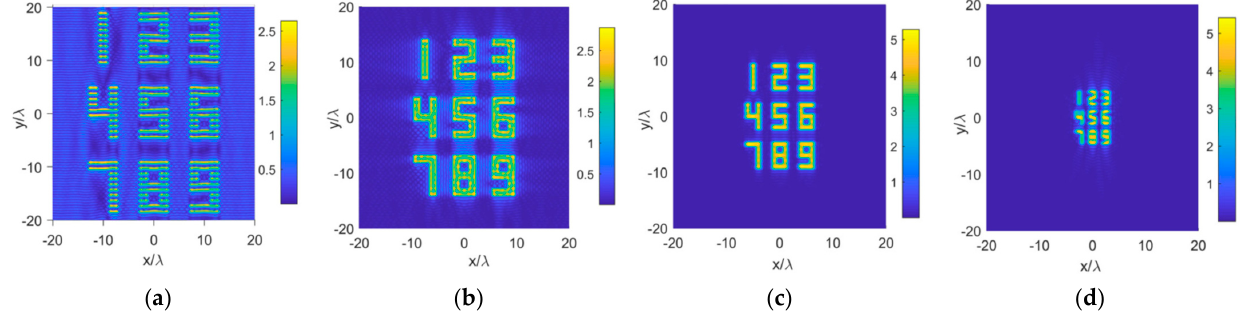
Figure 4. The reconstructed pictures of the four sources: ( a ) Case 1; ( b ) Case 2; ( c ) Case 3; ( d ) Case 4.